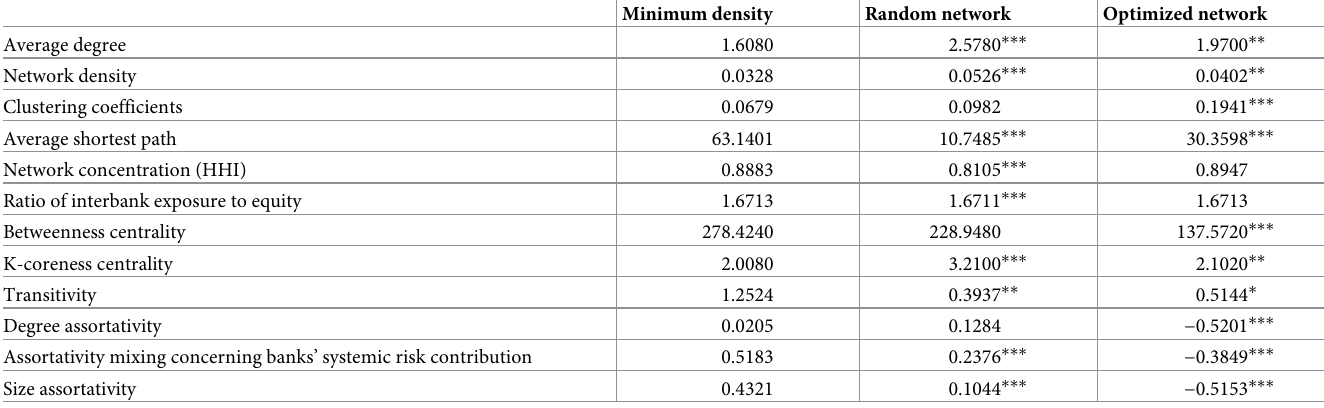
Table 4. Annually average results of topological